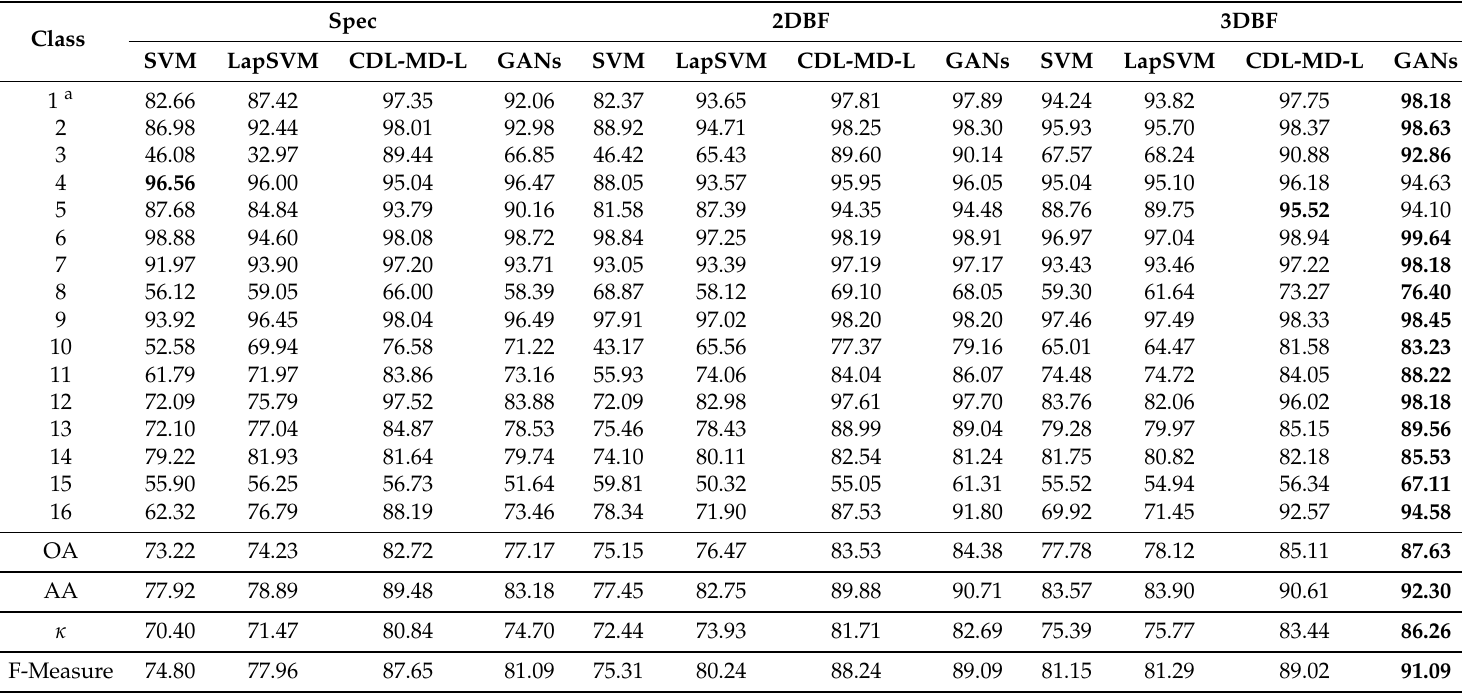
Table 6. Classification accuracy (%) of various methods for the Salinas data with 5 labeled training samples per class, bold values indicate the best result for a